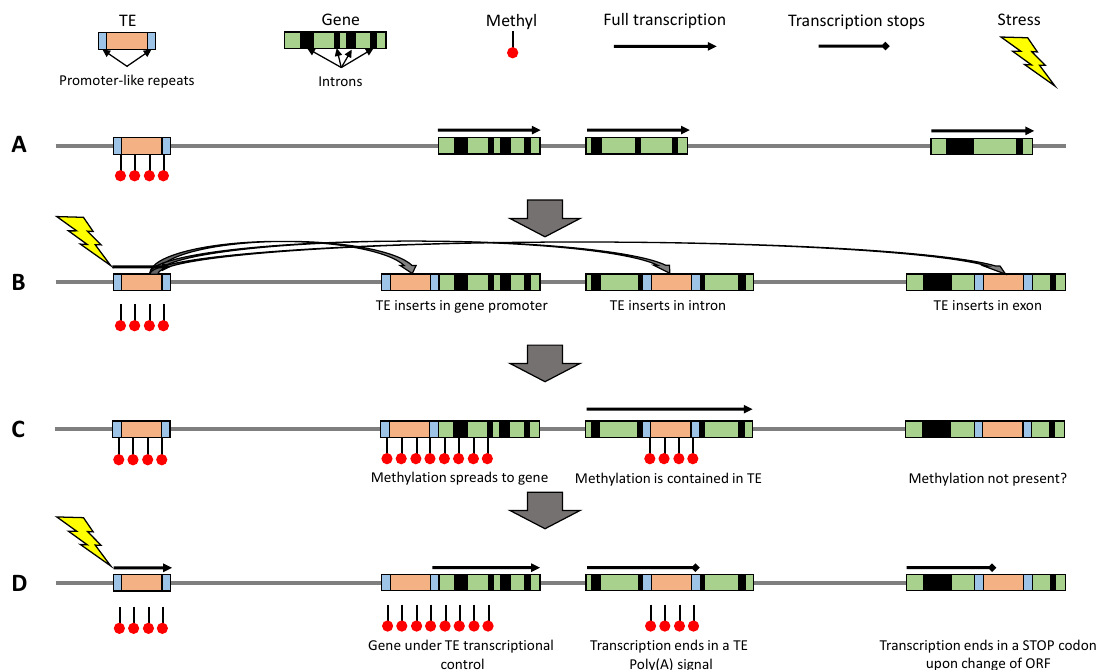
Figure 1. Epigenetic control of transposable elements TEs through methylation. ( A ) Under absence of elicitors a methylated TE remains silent and genes which are far from the TE can be transcribed normally; ( B ) Upon stress, the TE becomes hypomethylated and can be transcribed and transposed to new locations: A promoter region of a gene, an intron or an exon; ( C ) When normal conditions resume the original TE and the TEs located in the promoter and intronic regions of genes are silenced again through DNA methylation (RdDM.) Methylation from the TE inserted in the promoter of the gene spreads to the adjacent gene and either lowers or suppresses expression. Methylation in the intronic TE is usually contained and helps with correct splicing of the transcript. In the case of an insertion into an exon the result is commonly a disruption of the reading frame which renders a non-functional gene; methylation is rarer in TEs falling in exons [48]; ( D ) Upon a second round of stress silencing is lifted again. The first gene carrying a TE in its promoter can fall under the transcriptional control of the TE’s stress responsive motifs. Demethylation of the TE inserted in the intron of the second gene can result in a read-through transcript that ends prematurely on a cryptic polyA signal inside the TE. The TE insertion disrupting an exon will likely end transcription prematurely when the open reading frame (ORF) changes from the gene into the TE generating a stop